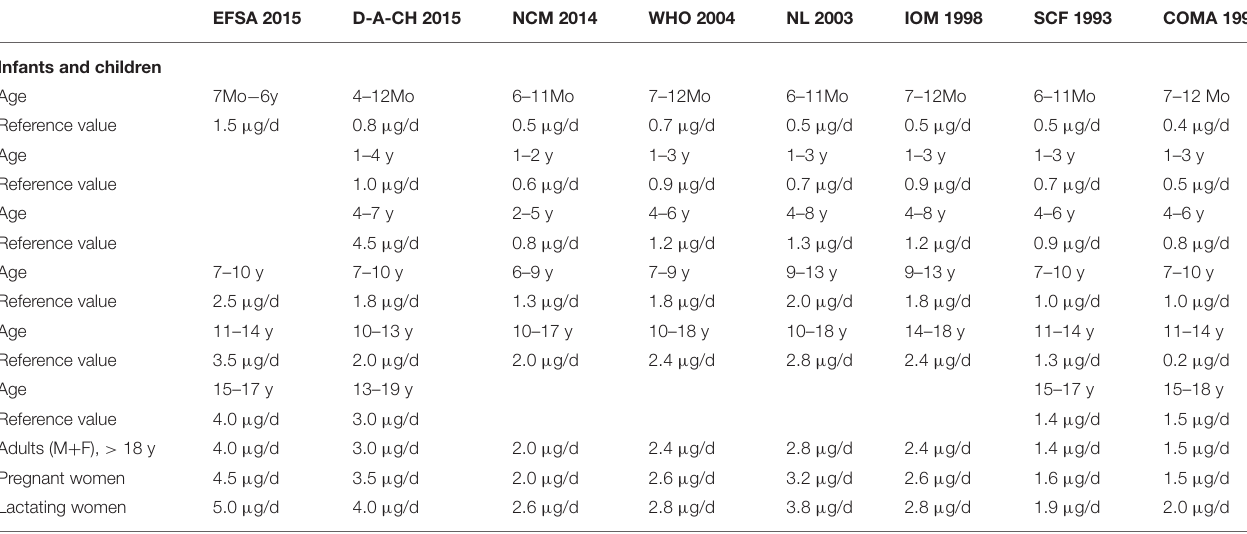
TABLE 3 | Dietary reference values for vitamin B12 (in µ g/d) in different age and sex groups as suggested by different